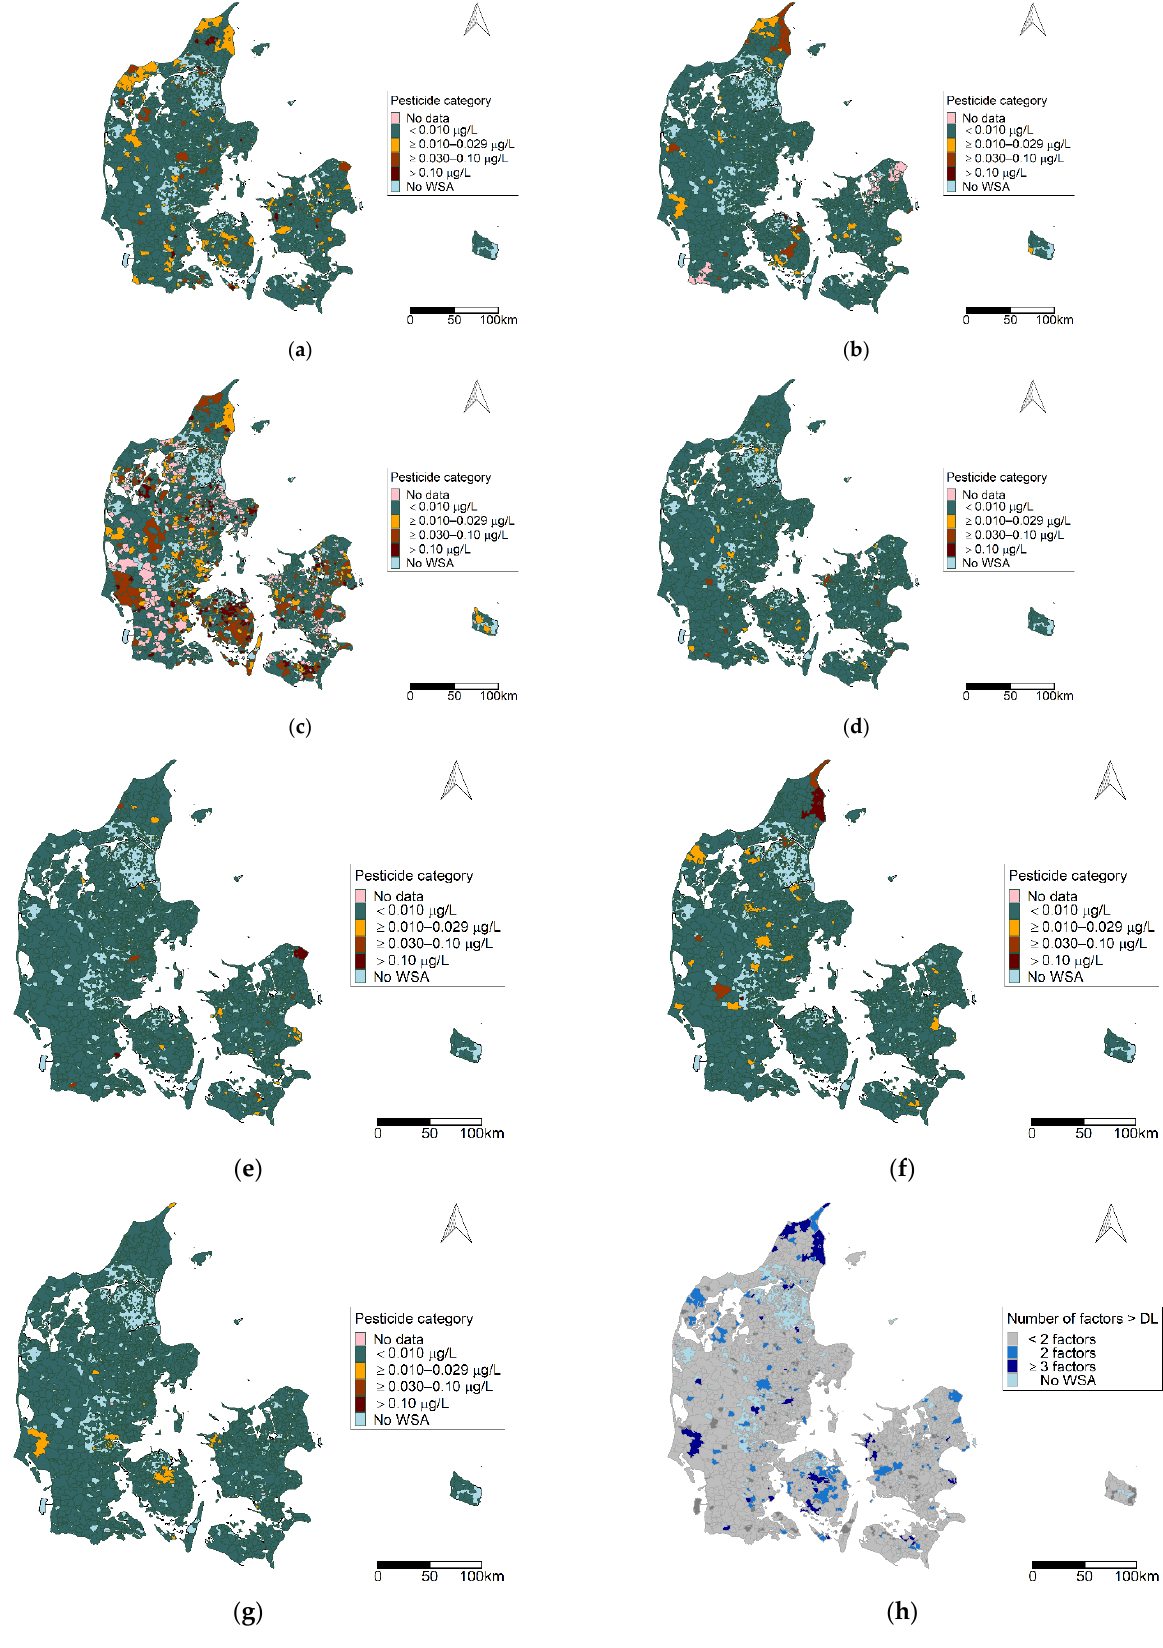
Figure 7. Geographic distribution of factor components, 2012 – 2018: ( a – g ) the geographic pattern of factors 1 – 7; ( h ) the number of factors represented at each WSA. Note that one WSA can represent multiple waterworks and shows the maximum category represented by the WSA. Abbreviations: WSA: water supply area. Map contains data from the Danish Agency for Data Supply and Efficiency, municipality borders, 2019.